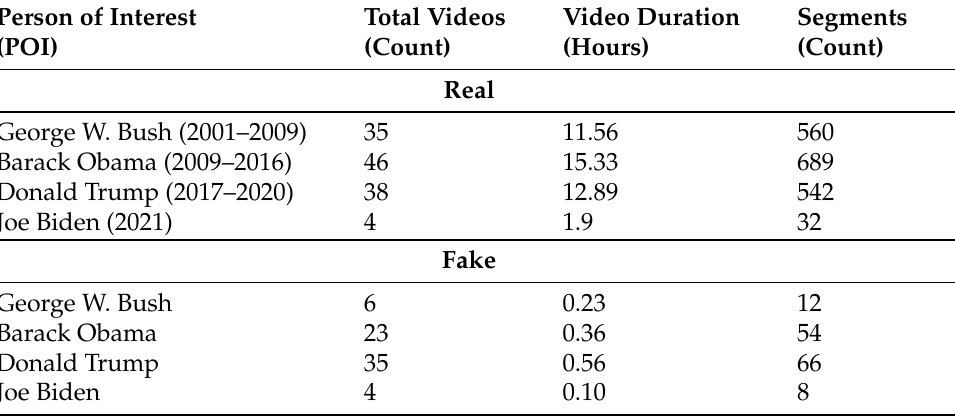
Table 2. Summary of the dataset: A comprehensive dataset was sampled from speeches of four recent US presidents. The Miller Center website is used to extract authentic video samples. For Deepfake samples, we trawl YouTube to extract related samples. These samples were further segmented into functional segments for keypoint extraction and training